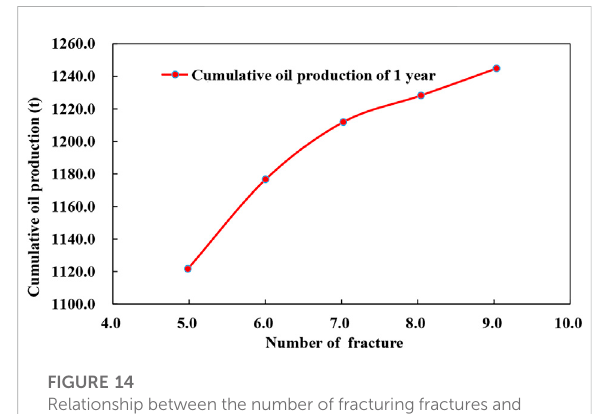
FIGURE 13 Relationship between fracture spacing and cumulative oil production.